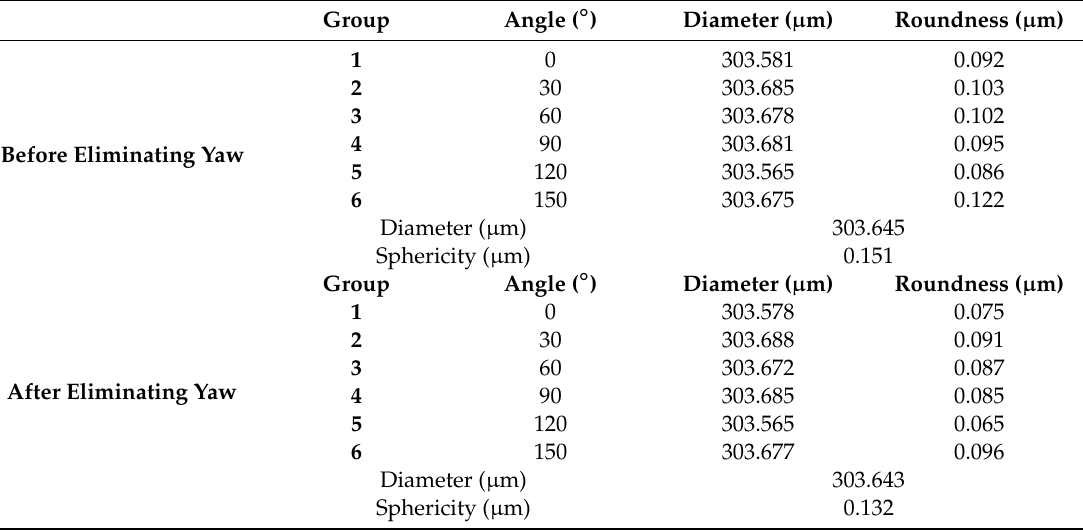
Table 1. Measurement results of circle dimensions in di ff erent